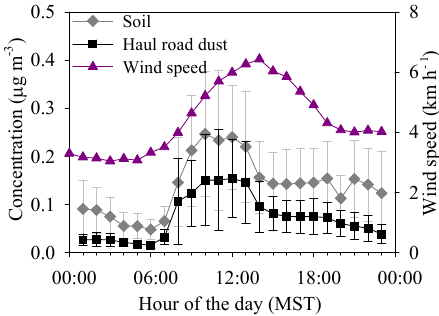
Figure 6. Average concentrations displaying the diurnal trends the soil factor (grey) and the haul road dust factor (black) at AMS13 during the intensive campaign and the average wind speeds between December 2010 and September 2012 (purple). Error bars represent 95% confidence intervals.